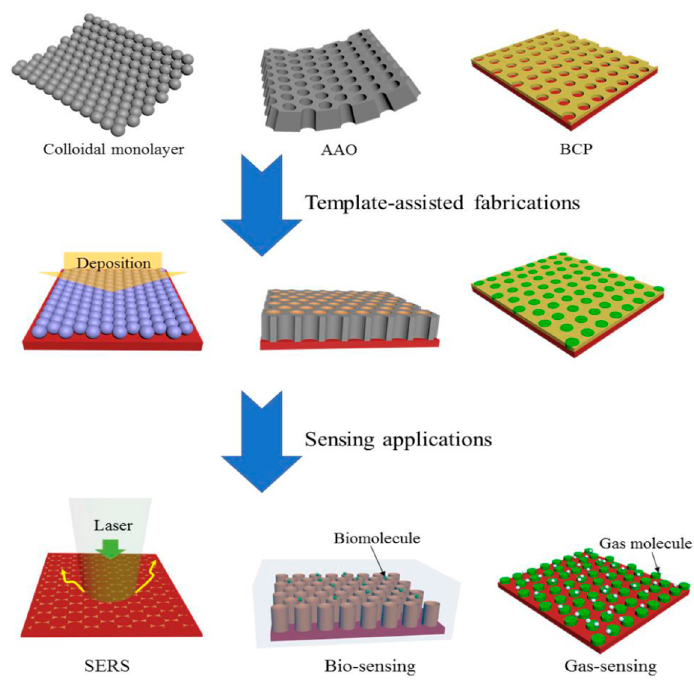
Figure 9. Template-assisted arrays. Adapted with permission from [145]. Copyright Wiley 2018.